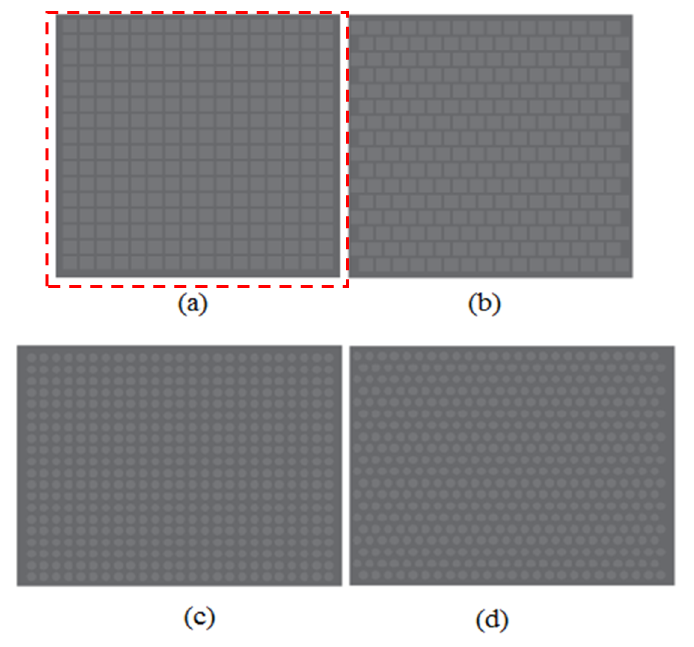
Figure 1. PET mask designs of ( a ) square cross sectional with square distribution, ( b ) square cross sectional with hexagonal distribution, ( c ) circle cross sectional with square distribution, and ( d ) circle cross sectional with hexagonal distribution.